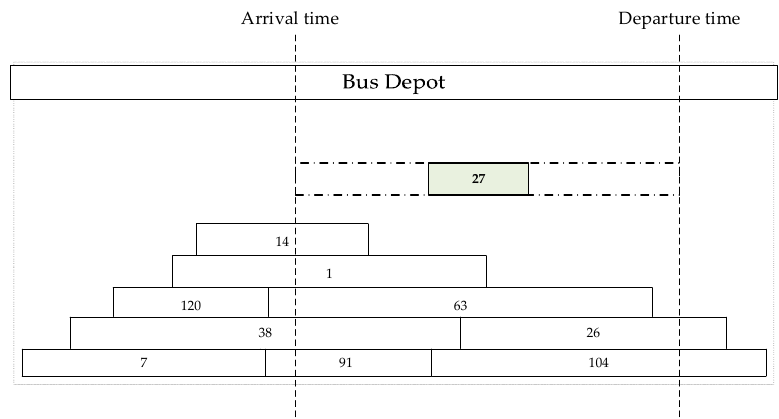
Figure 4. Graphical representation of the scheduling problem with several random buses already charging (white blocks) and a new bus arriving at the depot (green block).